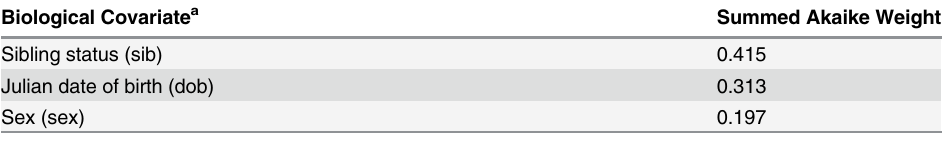
Table 2. Summed Akaike weights (from competing models) for each biological covariate affecting neonatal white-tailed deer survival at Fort Bragg Military Installation, North Carolina, 2011 – 2012. Biological Covariate a